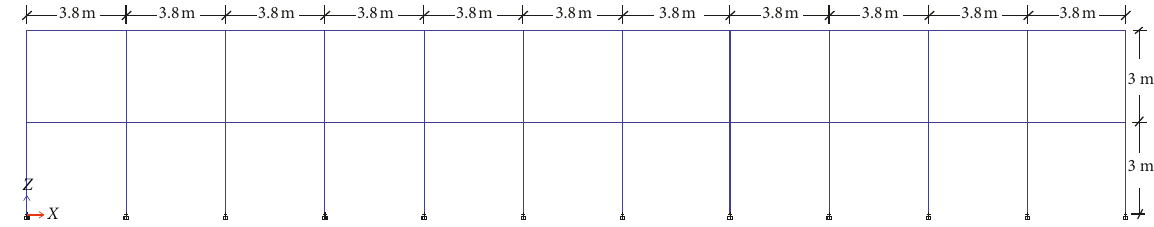
Figure 5: Elevation view of the considered building, indicating the story height of the superstructure. Table 2: Beam and column X-sectional and reinforcement